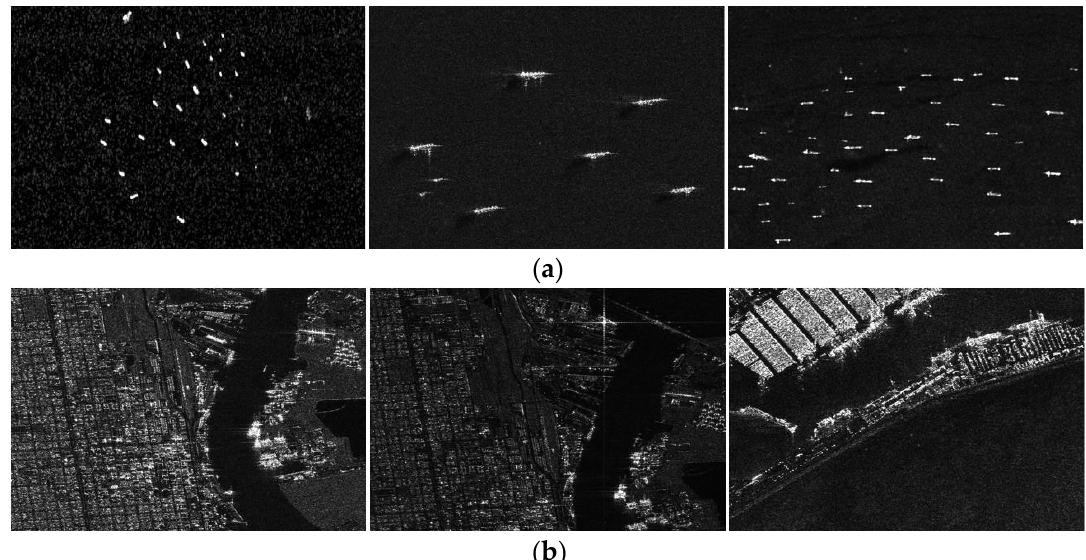
Figure 11. Ships in different situations in HRSID: ( a ) Small ships in SAR images; ( b ) Near-shore ships in SAR images.